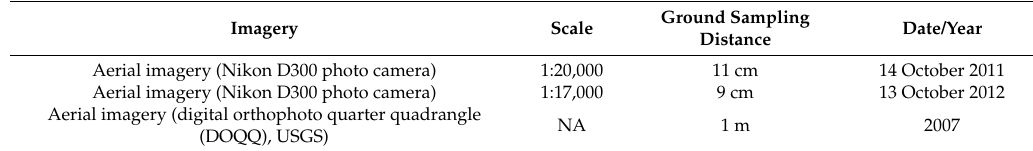
Table 1. List of aerial images of Goldstream Lake,